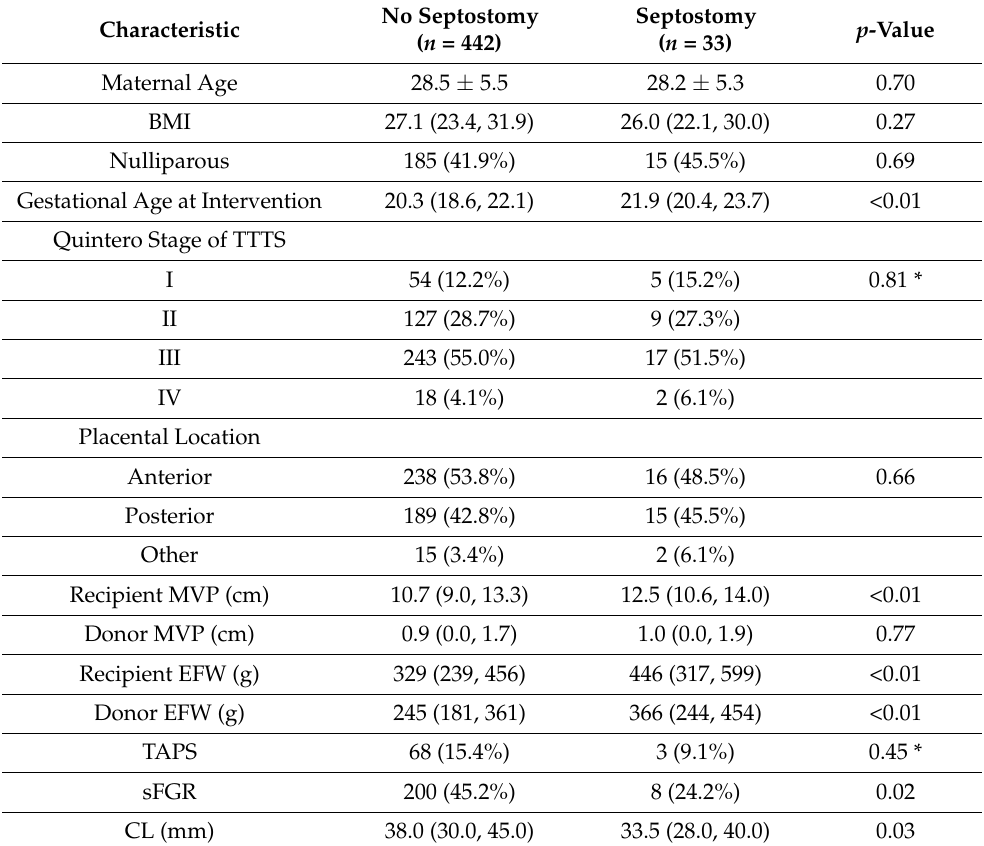
Table 1. Demographic and initial ultrasound